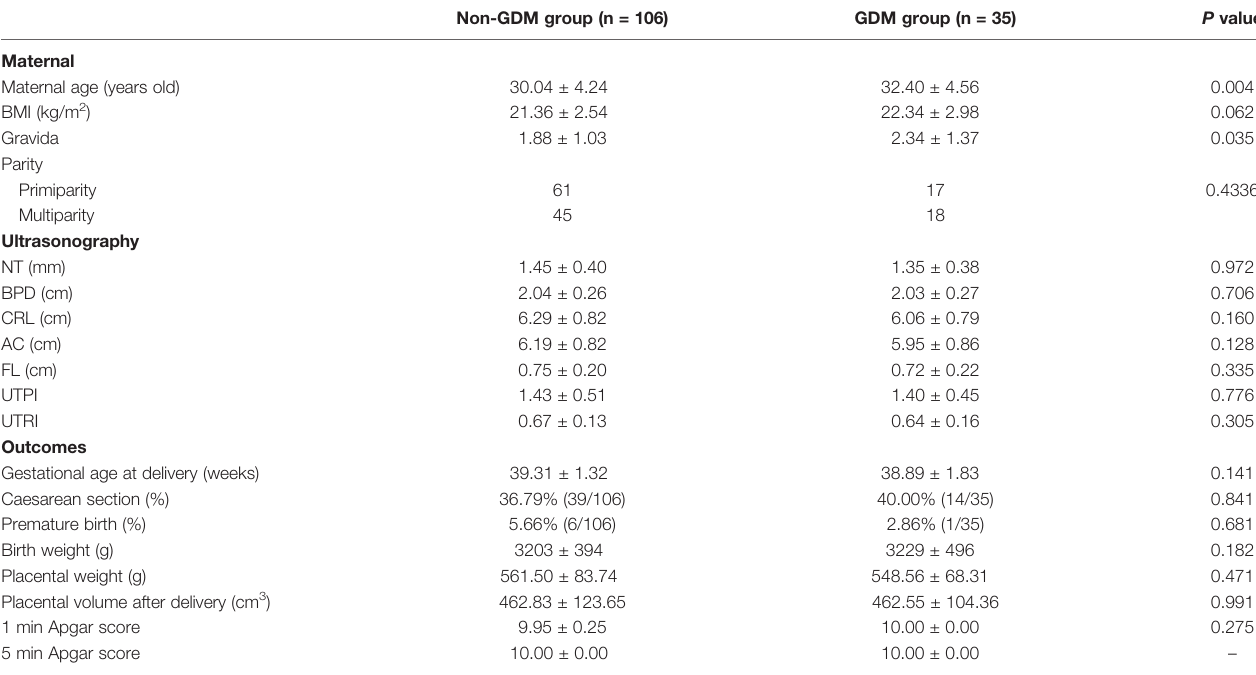
TABLE 1 | Comparison of clinical characteristics between non-GDM group and GDM